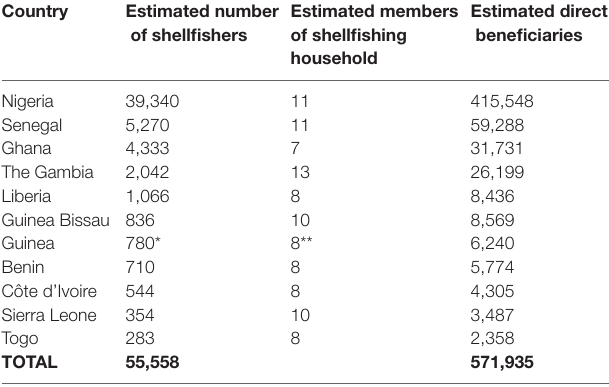
TABLE 1 | Total estimated number of shellfishers and estimated direct shellfisheries beneficiaries from shellfishers’ households in the coastal countries of West